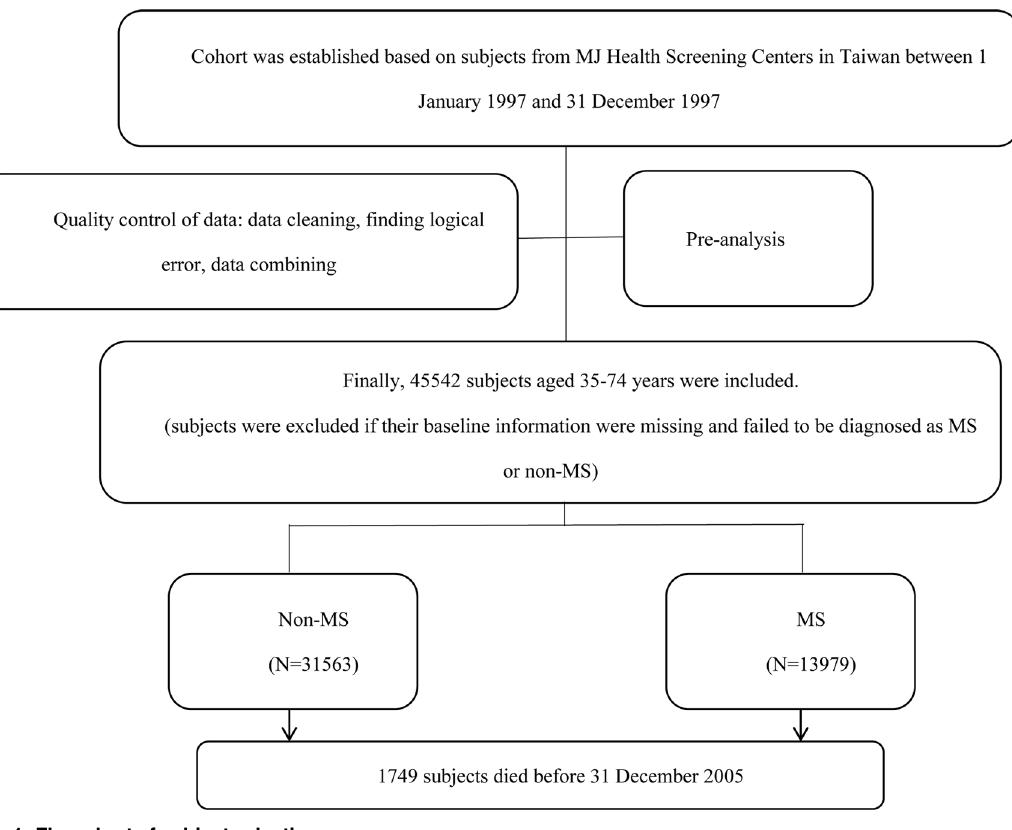
Fig 1. Flow chart of subject